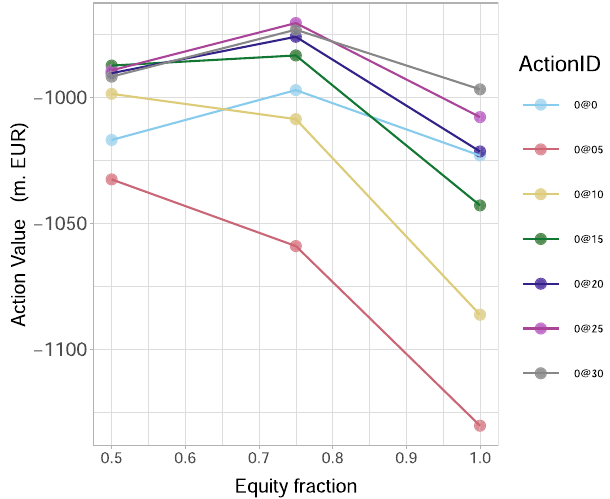
Fig. 9 | Theoptimalactionvalue Q * ( s 0 , a 0 )fortheEuropeanBanking Authority (EBA) network at time 0 as a function of the percentage of initial capital E i (0) available to fi nancial institutions i . In the legend, the ActionID 0@0 means no investment, 0@05 means investing 0.5 in all the nodes, etc. The results areobtainedforthepercentage α =0.005ofwealthlossupondefaultandshowthat the best action a * amongst a 0 ’ s (corresponding to the highest Q * ( s 0 , a 0 ) value) decreases (0@30 → 0@25 → 0@15) as E i (0)